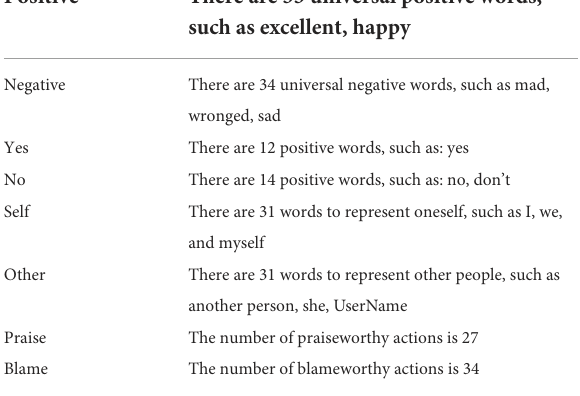
TABLE 5 Analysis of typical example sentences for each type of